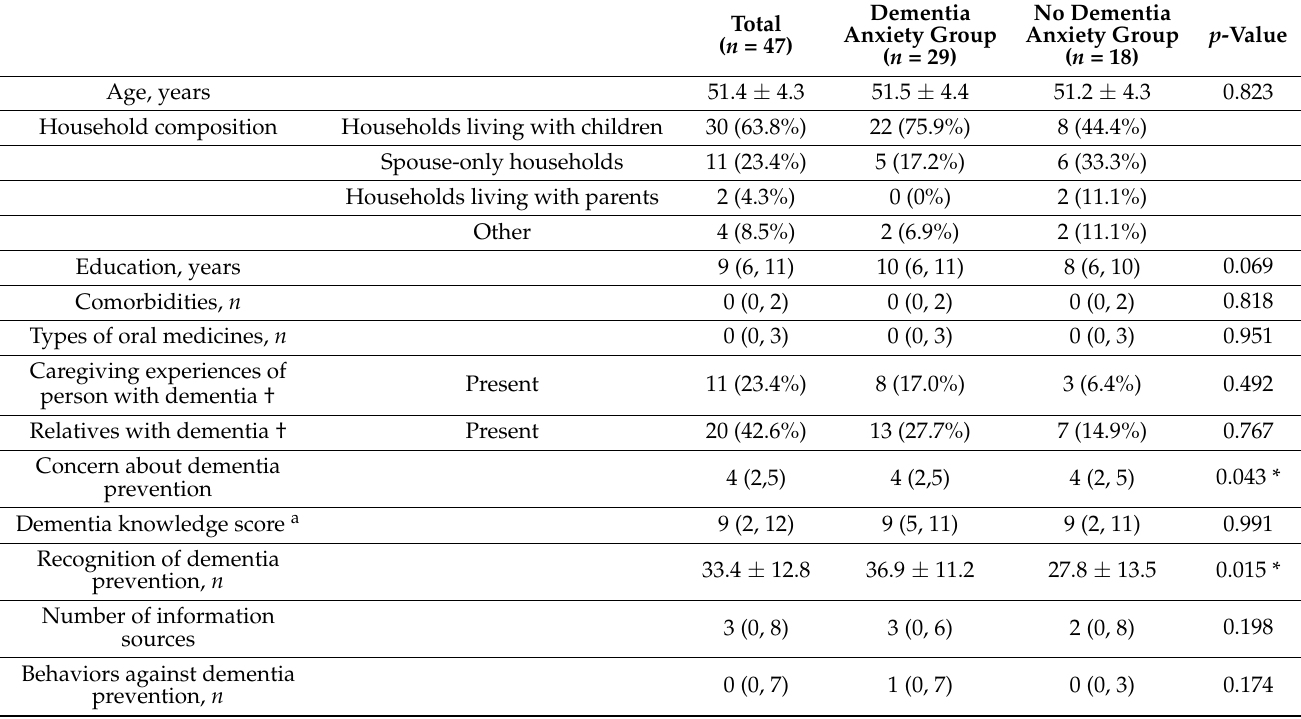
Table 1. Characteristics of the